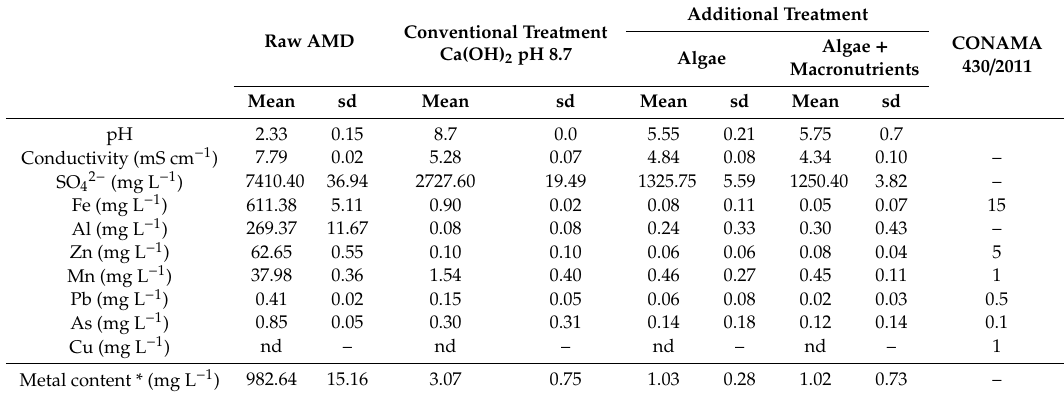
Table 1. Characterization of acid mine drainage (AMD) after conventional treatment—neutralization / precipitation with Ca(OH) 2 at pH 8.7—and additional treatment with growth of Scenedesmus sp.